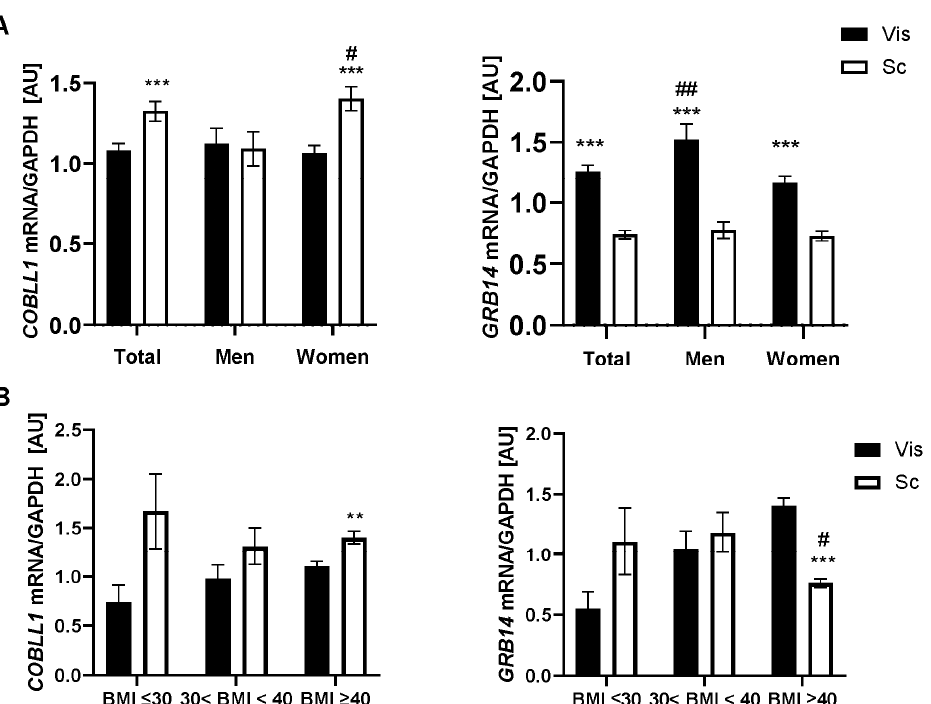
Figure 1. ( A ) COBLL1 and GRB14 mRNA expression in 524/560 paired human visceral (vis) and subcutaneous (sc) adipose tissue (AT) samples in the total cohort and grouped by sex (131/149 men, 393/411 women). Data are shown as mean ± SEM; *** for comparisons between sc and vis fat depot expression; # for comparison between men and women in the same AT depot; # p < 0.05; ## p < 0.01; *** p < 0.001. ( B ) COBLL1 and GRB14 mRNA expression in paired human visceral (vis) and subcutaneous (sc) adipose tissue (AT) samples grouped by obesity status (BMI < 30 kg/m 2 , n = 19; 30 ≤ BMI < 40 kg/m 2 , n = 47; BMI ≥ 40 kg/m 2 , n = 454). Mean ± SEM; ** sc vs. vis AT depot; # 30–40 kg/m 2 / ≥ 40 kg/m 2 vs. <30 kg/m 2 depot; # p < 0.05; ** p < 0.01; *** p < 0.001.